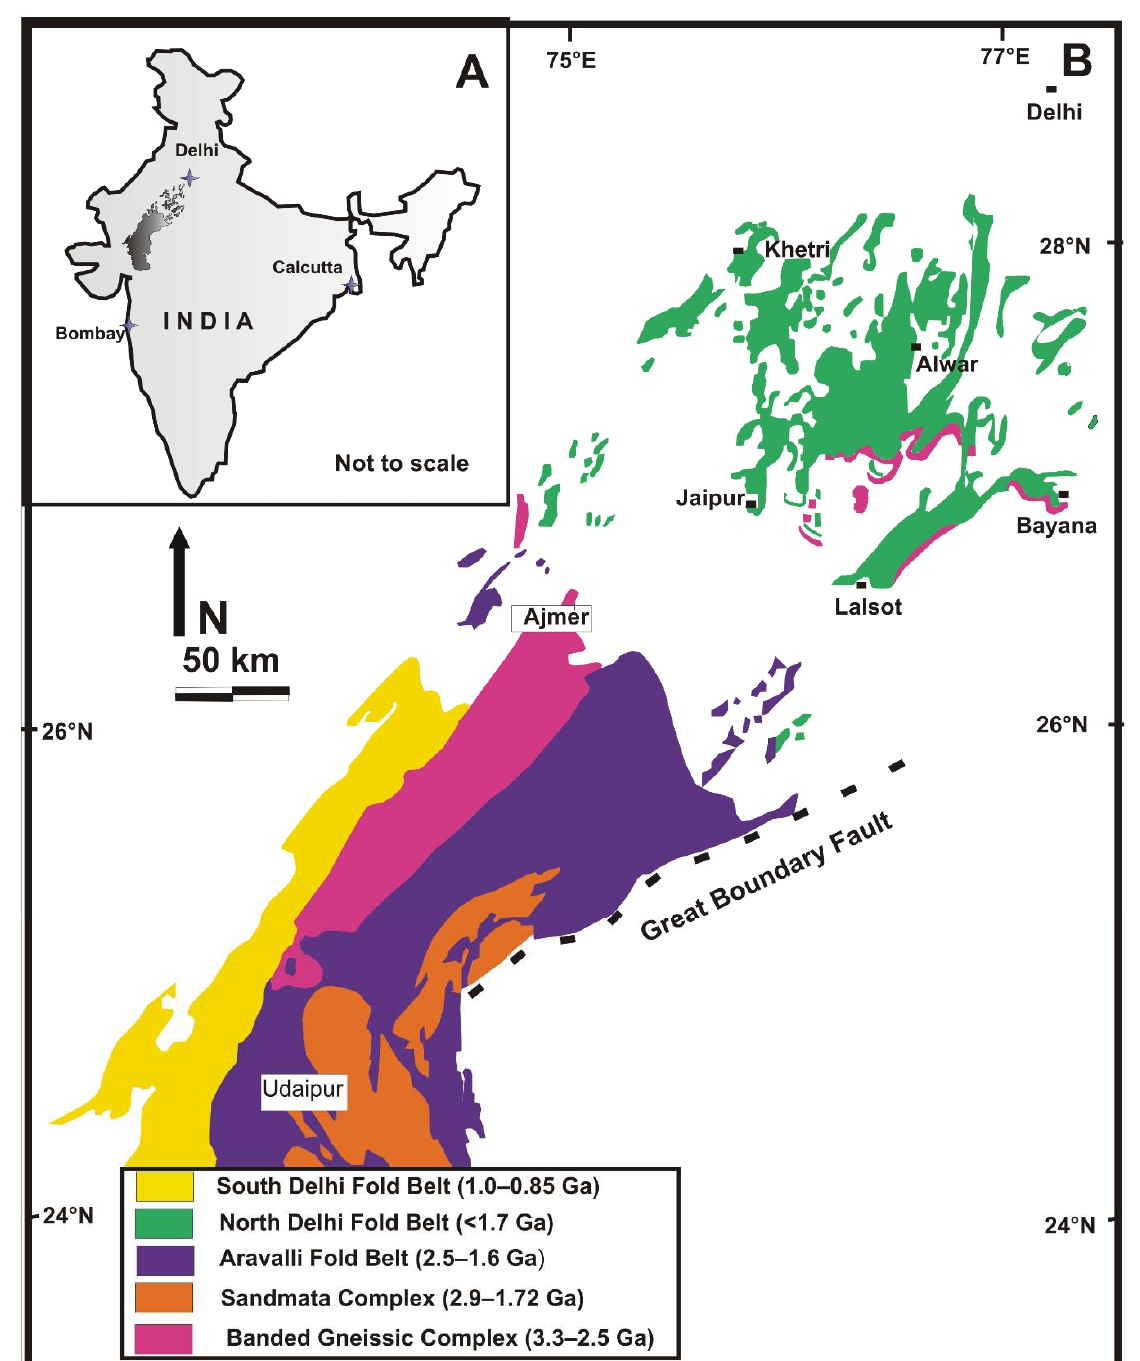
Figure 1. ( A ) Location of Delhi Fold Belt in India map; ( B ) Generalized regional geological map of the Delhi Fold Belt (modified from [28]).